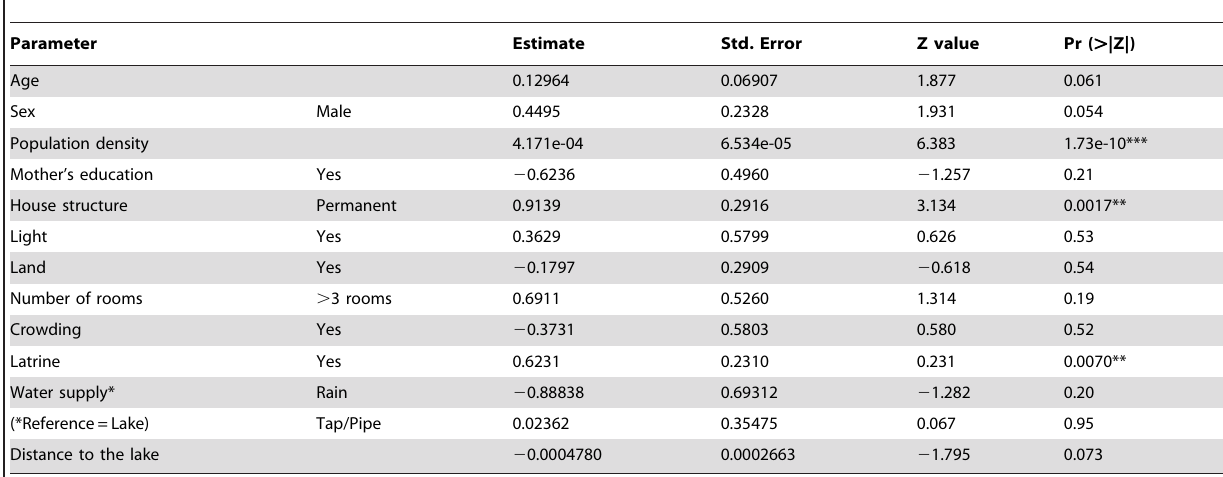
Table 4. Bivariate negative binomial generalized linear model (NB-GLM) for Schistosoma mansoni infection risk among schoolchildren Mbita,